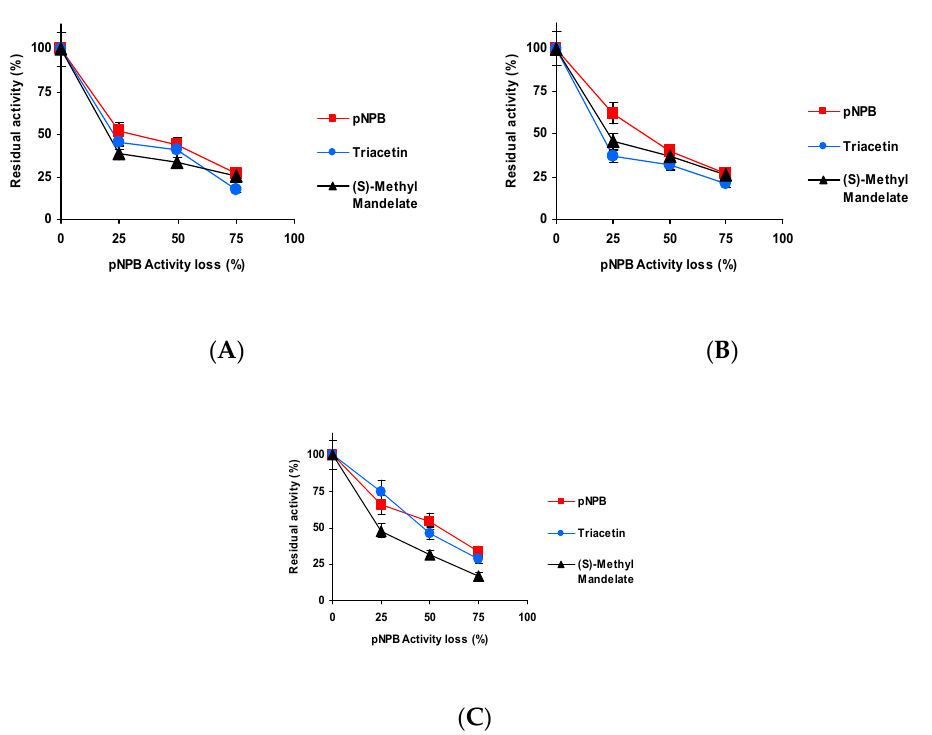
Figure 4. Effect of the inactivation pH on the residual activity versus different substrates of CALB biocatalysts activity blocked with glycine. Inactivation was performed at ( A ) pH 5.0 and 80 °C, ( B ) pH 7.0 and 75 °C and ( C ) pH 9.0 and 60 °C. The substrates used were: p NPB, triacetin, and ( S )-methyl mandelate. Other specifications may be found in Methods section. Figure 5 shows the results using the biocatalysts blocked with ethylenediamine (EDA). The differences with the different substrates are more significant for this biocat- alyst. Again, the slowest inactivation is observed using p NPB, only at pH 9 is the inacti- vation clearly more rapid using ( S )-methyl mandelate than using triacetin.